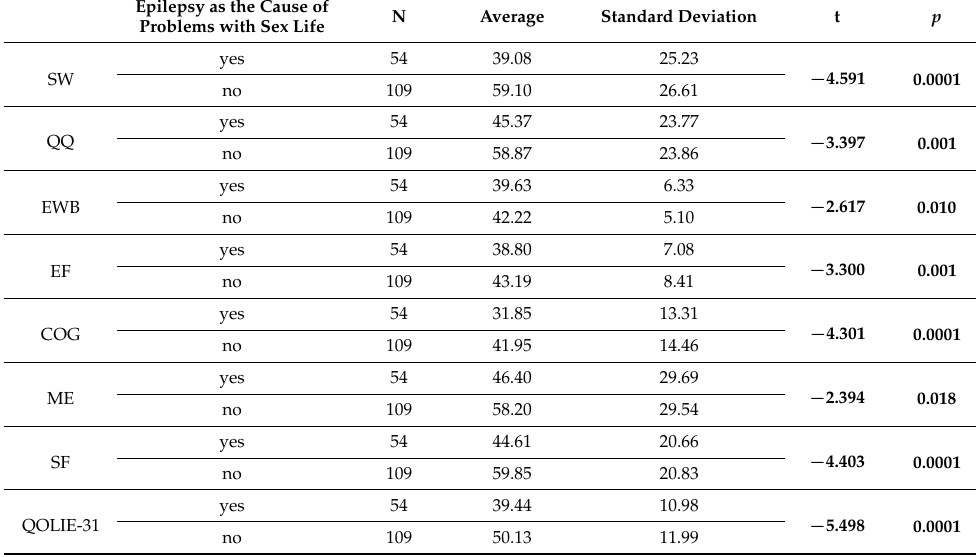
Table 5. QOLIE-31 results in the groups declaring that epilepsy was vs. was not the cause of problems with sex life, a comparative analysis (statistically significant correlations p ≤ 0.001 in